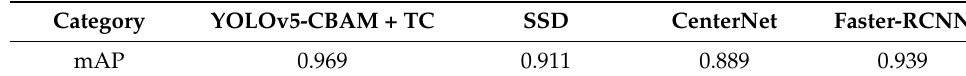
Table 4. Comparison between mainstream detection algorithms.